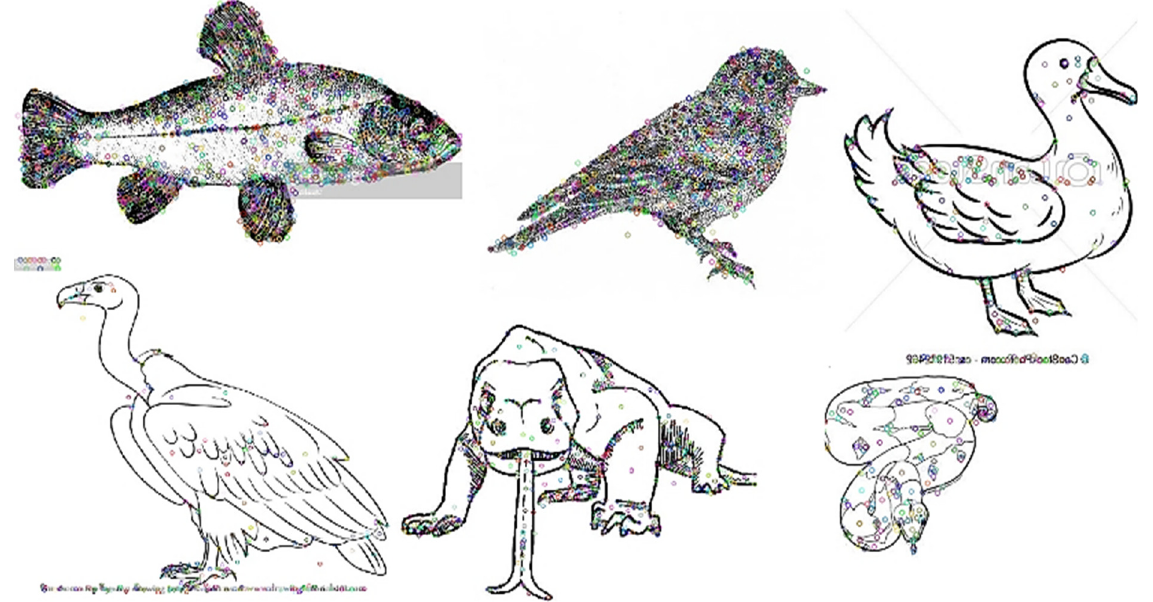
Figure 6. Extracted keypoints using SIFT for the training image of each pair [42].